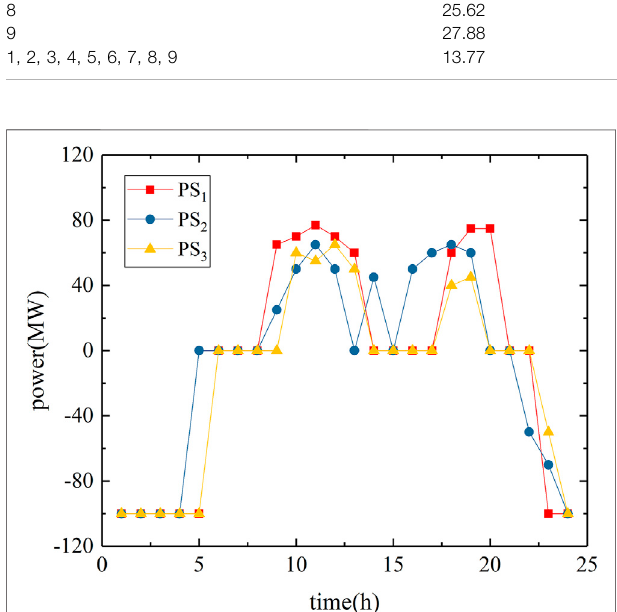
FIGURE 4 | Output curve of the pumped storage